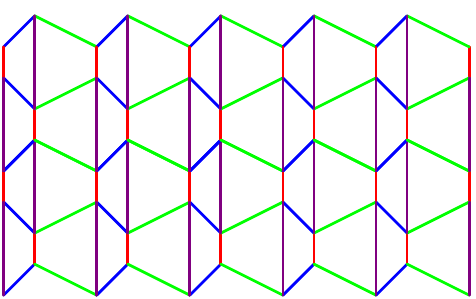
Fig. 31: Tiling with equal quadrilaterals (D).